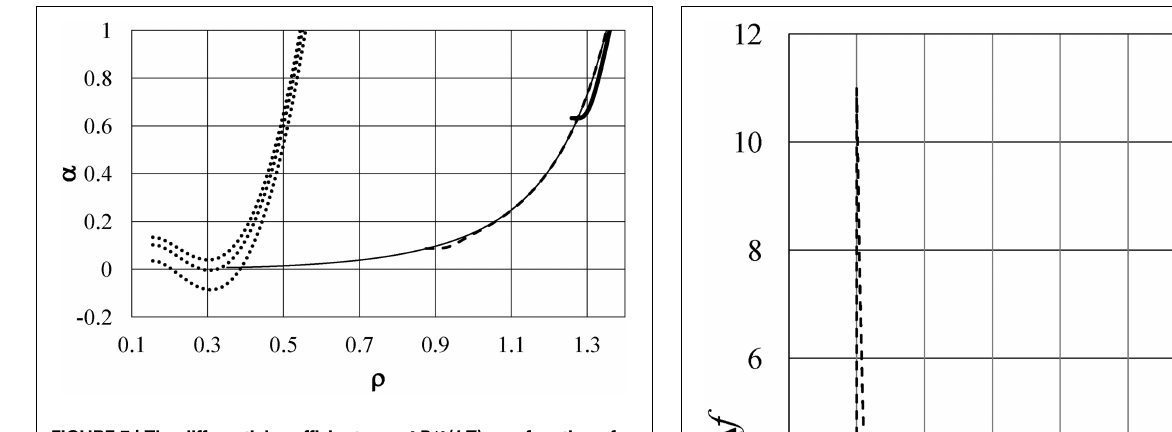
FIGURE 7 | The differential coefficients α = ∂ P /∂ ( kT ) as a function of density. Dotted lines are at T ( ◦ C) = + 20, + 4, and − 20 from the top to the bottom of the figure, respectively, for Model φ 6 . Thin full, dashed, and thick full lines are α/ 100 for kT c = 0 . 896, kT = 0 . 372, and kT = 0 . 0324, respectively, for Model φ 5 .